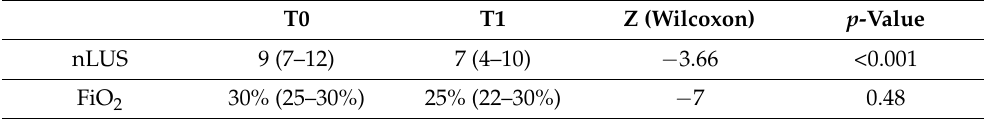
Table 2. nLUS, oxygen requirement before (T0) and after CPAP